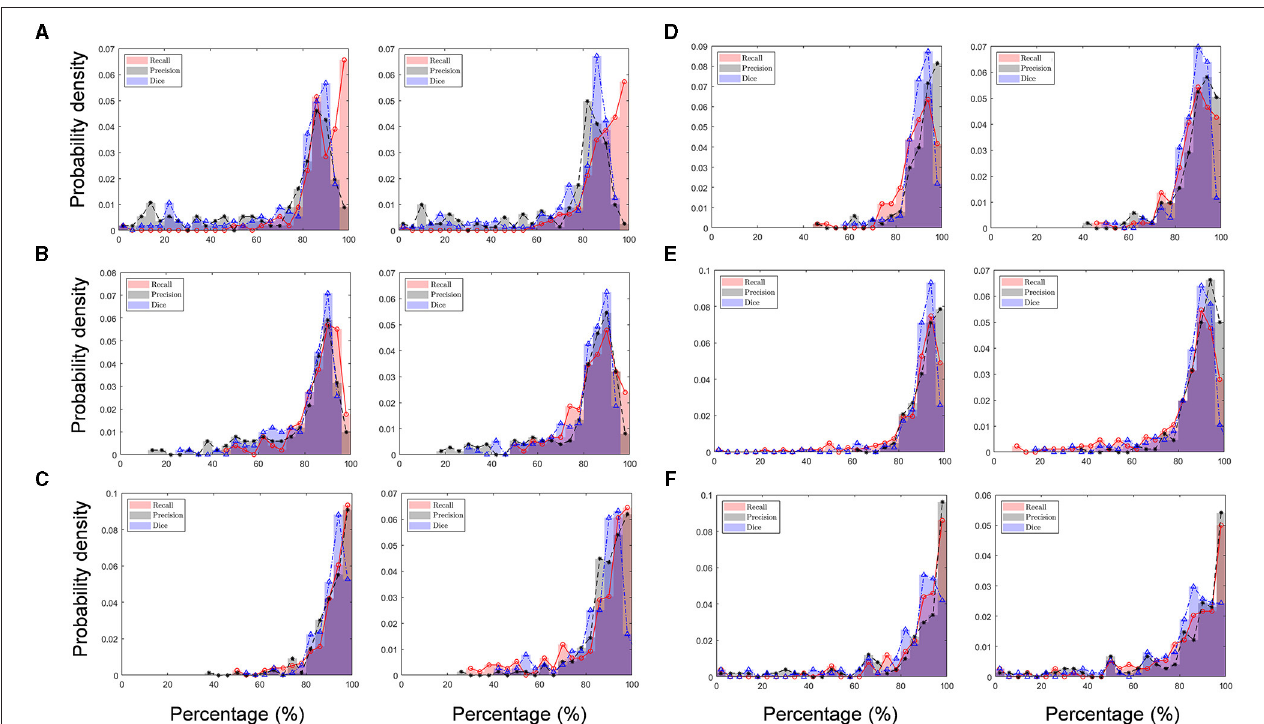
FIGURE 10 | Validation of performance (precision, recall, and Dice coefficient) of the stromata contour algorithm (SCDA) in recognizing “true stromata” compared to human rater A (left panels) and human rater B (right panels) on (A) Sample A, (B) Sample B, (C) Sample C, (D) Sample D, (E) Sample E, (F) and Sample F.